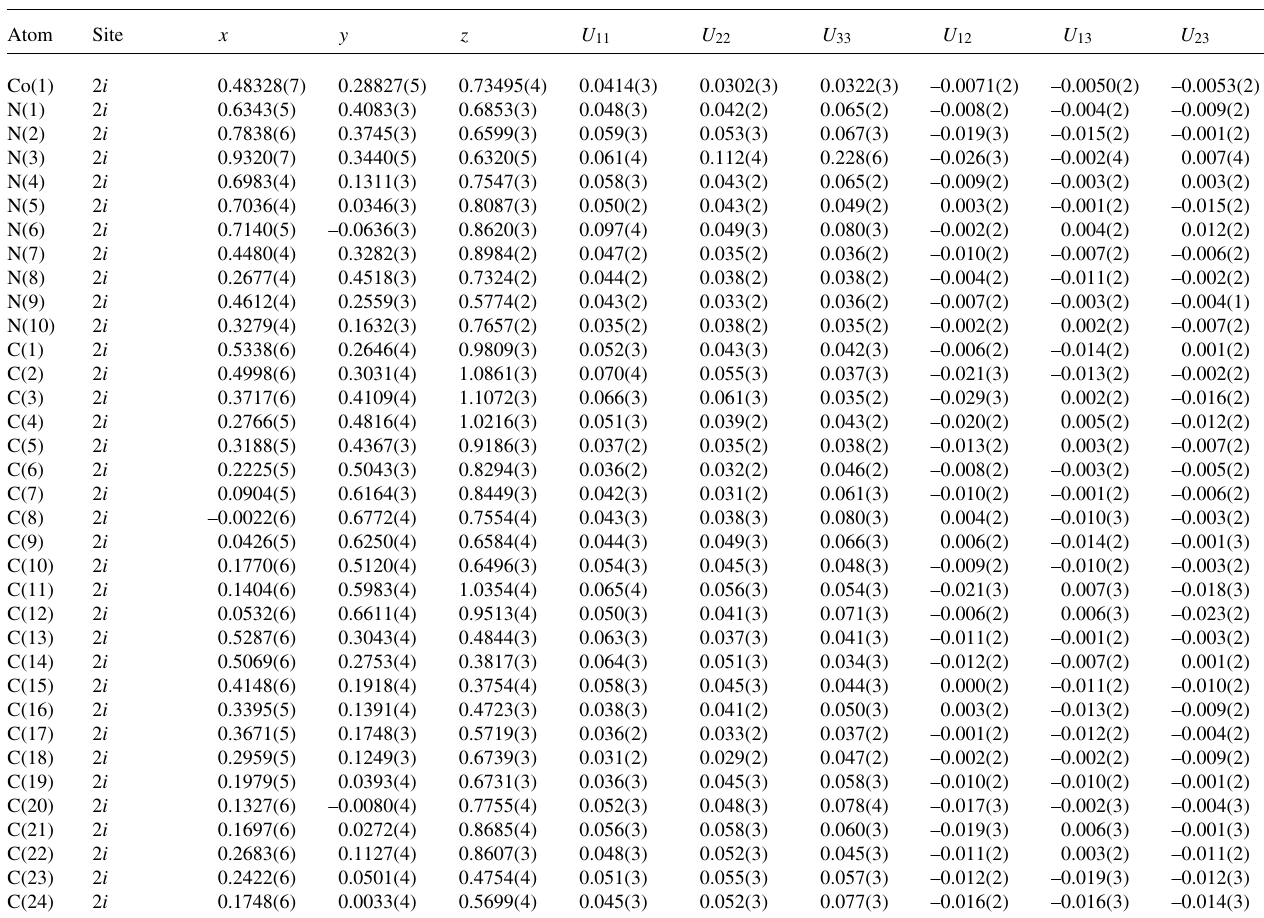
Table 3. Atomic coordinates and displacement parameters (in Å 2 ) .